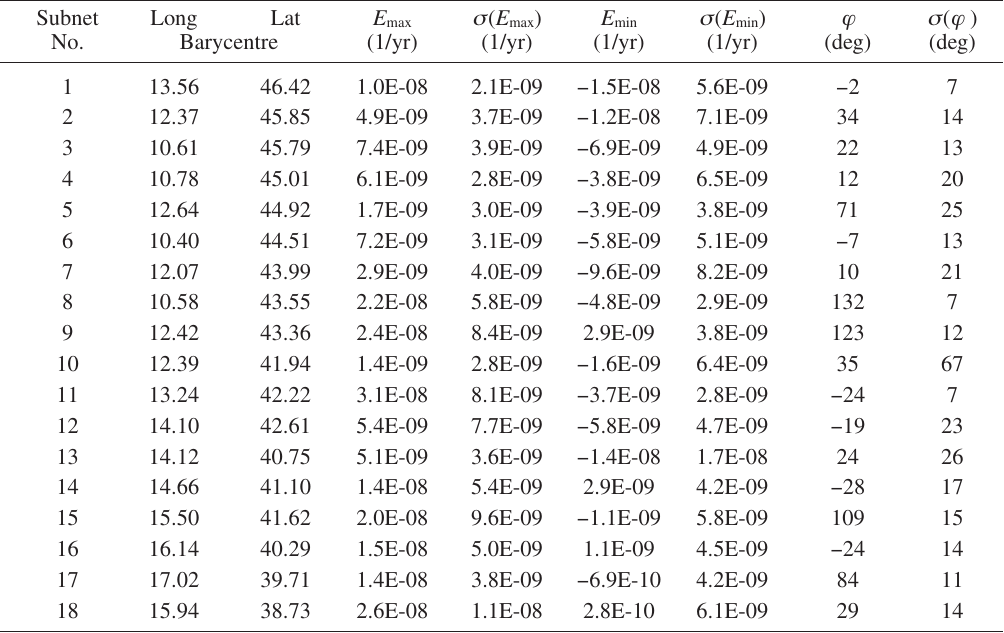
Table 1.I. Principal strain-rates and 1 σ uncertainties computed in the polygonal and triangular regions of fig. 1.2. Positive and negative values represent extension and contraction respectively ( ϕ is the azimuth of E min ).